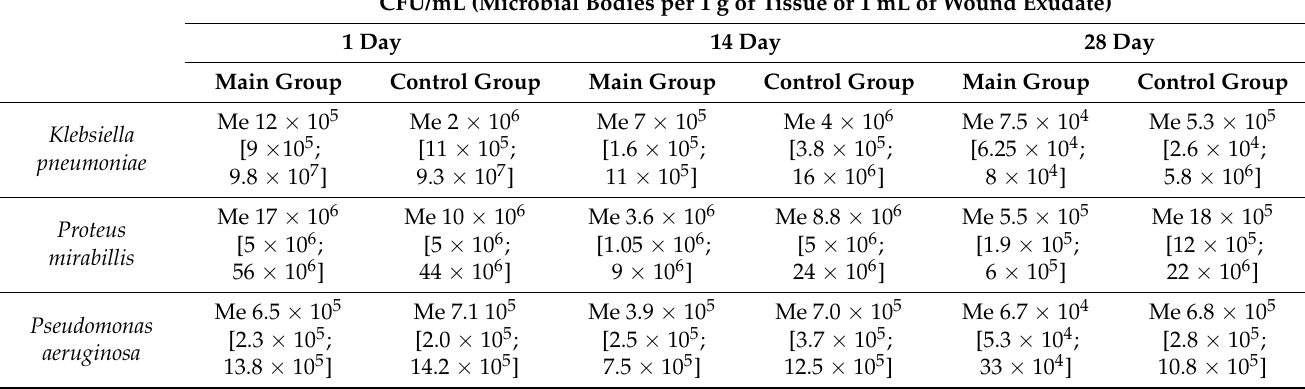
Table 4. Dynamics of the level of microbial contamination of